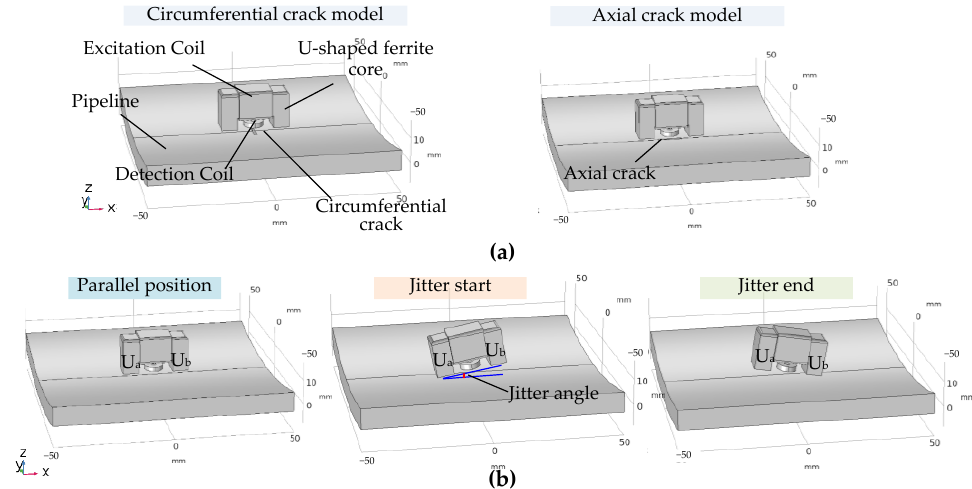
Figure 5. Simulation models for the detection of balanced-field electromagnetic technique: ( a ) Crack detection model; ( b ) Model of sensor jitter.